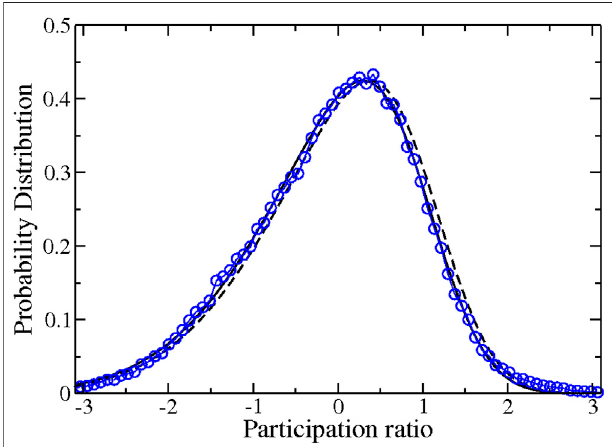
FIGURE 7 | Distribution of the normalized participation ratio, η (cid:1) ( τ κ − 〈 τ 〉 κ ) / σ κ , for the 2018 election and zone ( I ) , in blue dots with lines. The black line corresponds to a fi tting for the data using a skewed Gaussian, given by Eq. 3 . The broken black line corresponds to the same distribution but ruled by the single parameter related to the correlation between the participation ratio and the difference of the Nominal List and the numberofvoters,properlystandardized.Seethediscussion,in Section4 ,for explanation. The shift of the theoretical curves is around